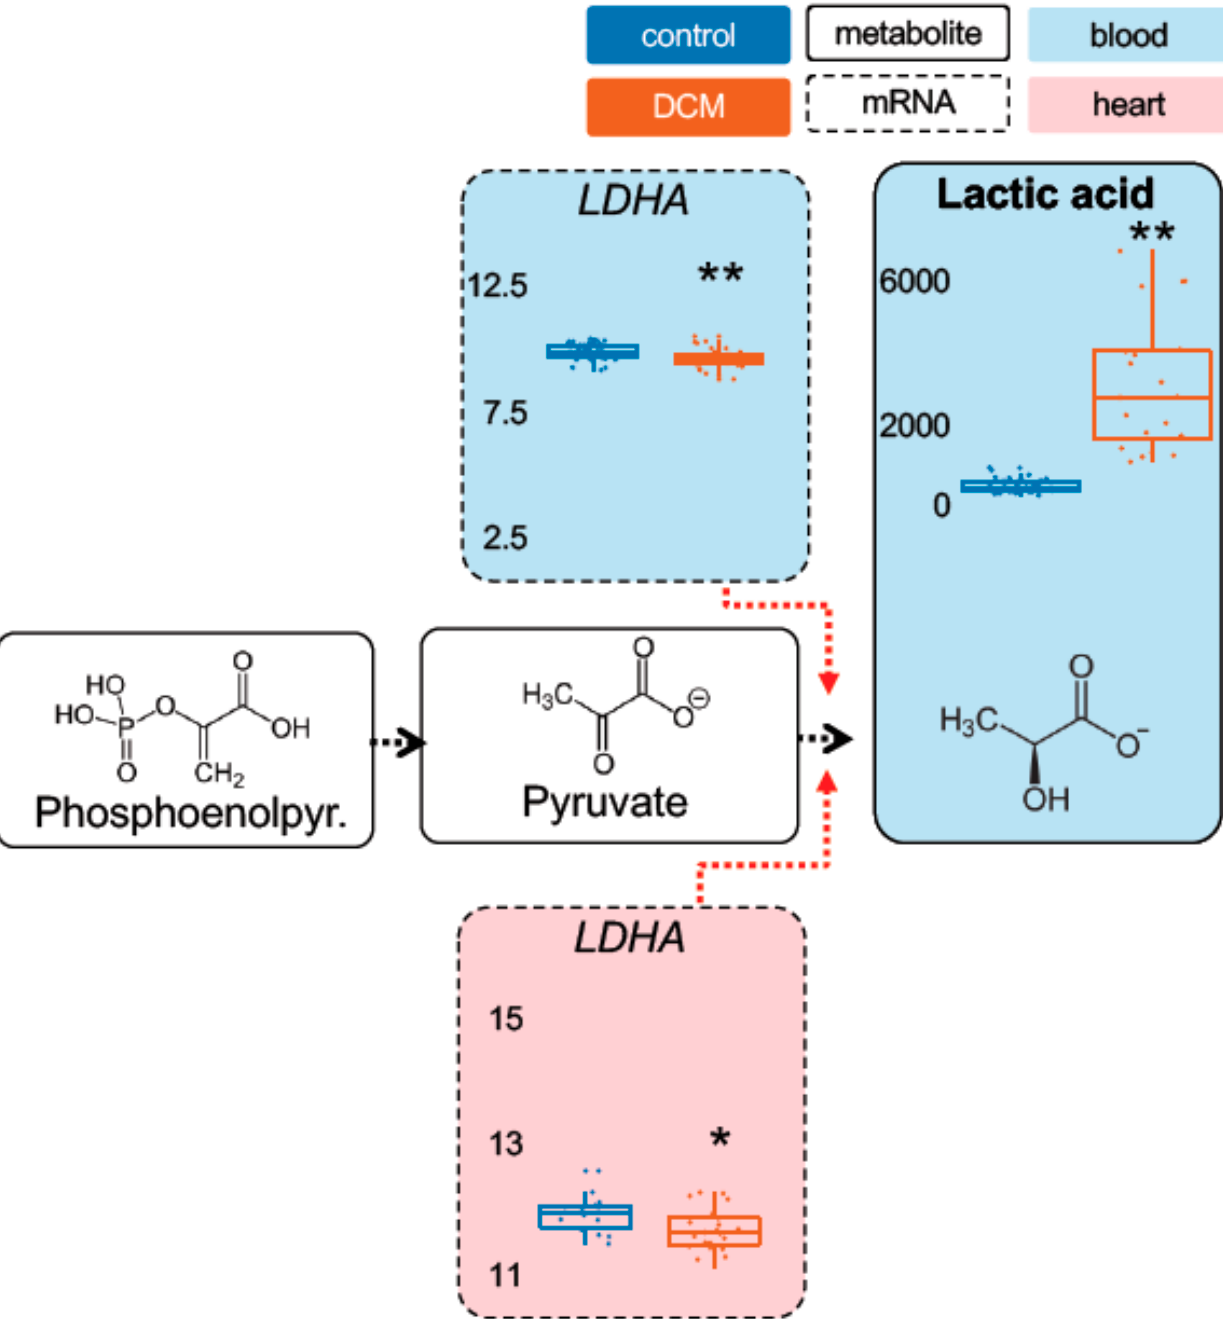
Figure 2. Detection of increased lactate levels. Following glycolysis, lactic acid is significantly increased in the stage 1 cohort, coinciding with decreased LDHA expression in blood but not in myocardial tissue. Same color and symbol annotation as in Figure 1. RNAseq expression is given as (rlog-)normalized read counts. Metabolite concentrations are shown as [ µ M]. *: p < 0.05; **: p < 0.01. LDHA = lactate dehydrogenase A.